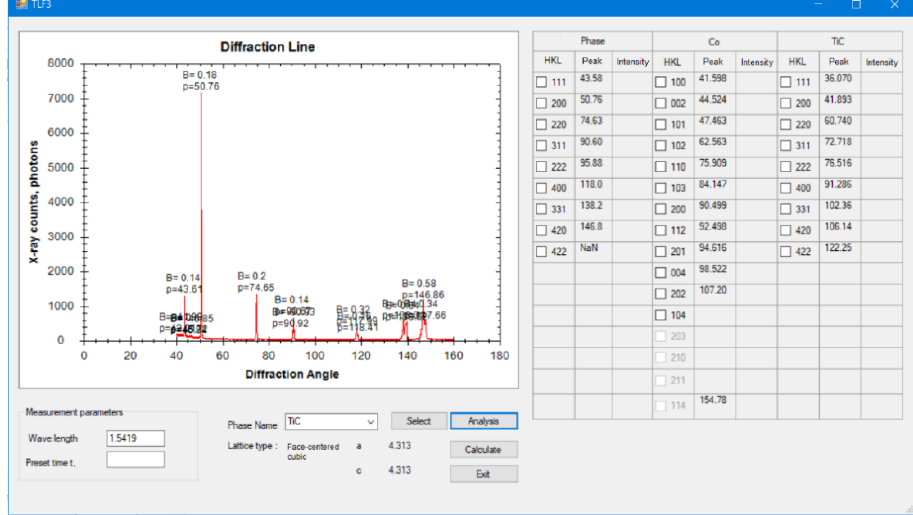
Figure 8. Dialog box for determining phase ratio of triple-phase carbide T15K6.